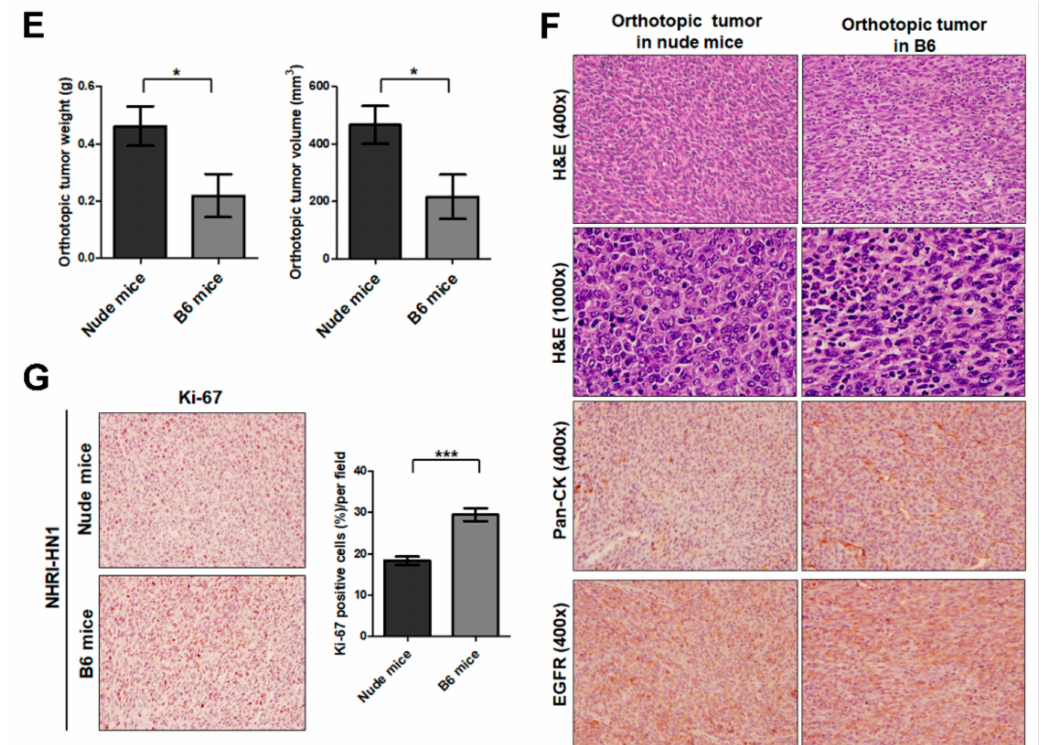
Figure 2. Tumor growth of M1-2 and M2-3 cells in nude mice and B6 mice. ( A ) Quantification of tumor weights (left panel) and volumes (right panel) in nude mice subcutaneously injected with 10 6 M1-2 ( n = 3) or M2-3 cells ( n = 3) and sacrificed at 98 days post-inoculation. ( B ) Histological examination of the subcutaneous xenografts in nude mice with H&E staining (left panel) and IHC with anti-pan CK (right panel) at 400 × magnification. Asterisks (*) indicate representative keratinization and keratin-pearl formation. ( C ) Quantification of tumor weights (left panel) and volumes (right panel) in nude mice subcutaneously injected with 10 6 NHRI-HN1 ( n = 4) or NHRI-HN2 cells ( n = 4) and sacrificed at 42 days post-inoculation. ( D ) Measurement of the tumor weights (left panel) and volumes (right panel) in B6 mice orthotopically injected with 5 × 10 5 NHRI-HN1 ( n = 20 in total for four independent experiments) or NHRI-HN2 cells ( n = 3) and sacrificed at 36–40 days post-inoculation. ( E ) Quantification of tumor weights volumes in nude mice and B6 mice orthotopically injected with 5 × 10 5 NHRI-HN1 cells ( n = 7 in total for two independent experiments) and sacrificed at 40 or 32 days post-inoculation. ( F ) Histological examination of NHRI-HN1 tumors in nude mice and B6 mice with H&E staining (upper panels) at 400 × and 1000 × magnifications and IHC with anti-pan CK (middle panel) and EGFR (lower panel) at 400 × magnification. ( G ) Representative Ki-67-labeled NHRI-HN1 tumors are shown in the left panel. The percentage of positive Ki-67 signals was determined in NHRI-HN1-generated tumors in nude mice and B6 mice. Error bars represent SE. * p < 0.05; *** p <